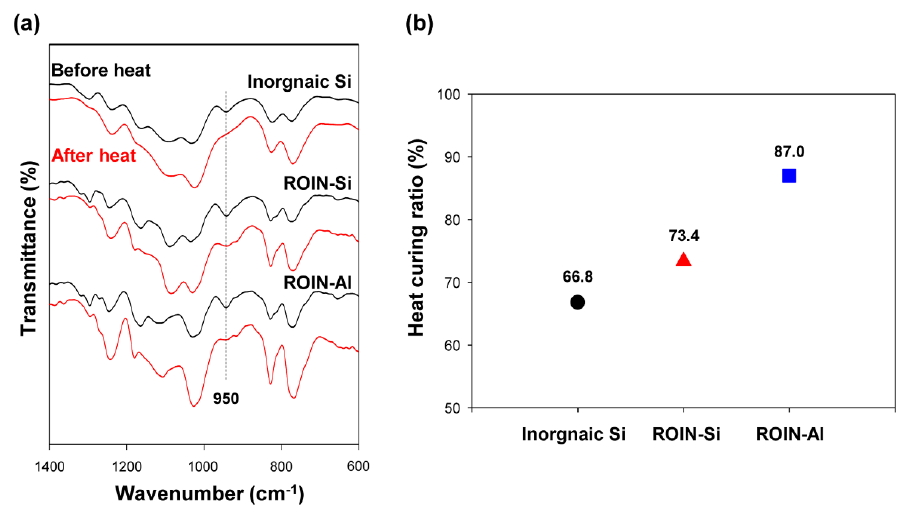
Figure 8. ( a ) FTIR spectra of the epoxy–acrylate composites containing inorganic silica or reactive hybrid nanoparticles before (black) and after (red) heat curing. ( b ) Heat curing ratios of the composites with inorganic silica or reactive hybrid nanoparticles.